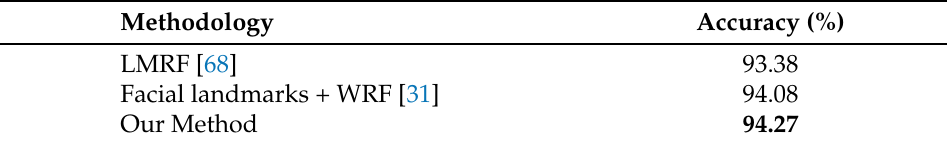
Table 8. Performance comparison on KMU-FED